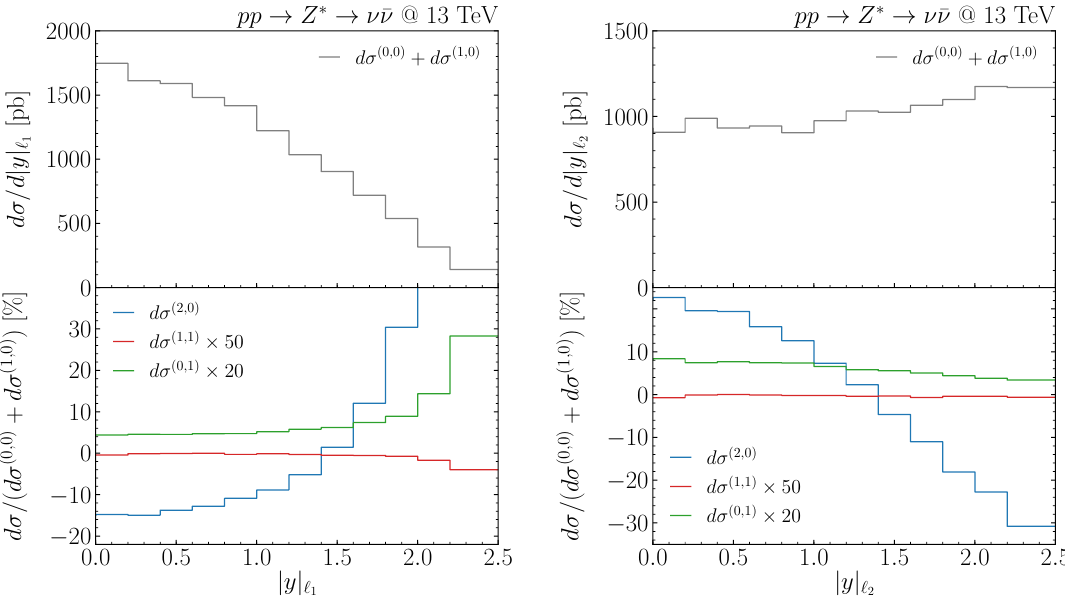
Figure 2 . Rapidity distributions for the hardest (left) and softer (right) lepton. The upper panel shows the NLO QCD prediction, while the lower panel shows the NNLO QCD (blue), NLO QED (green) and mixed (red) corrections, normalized to the NLO